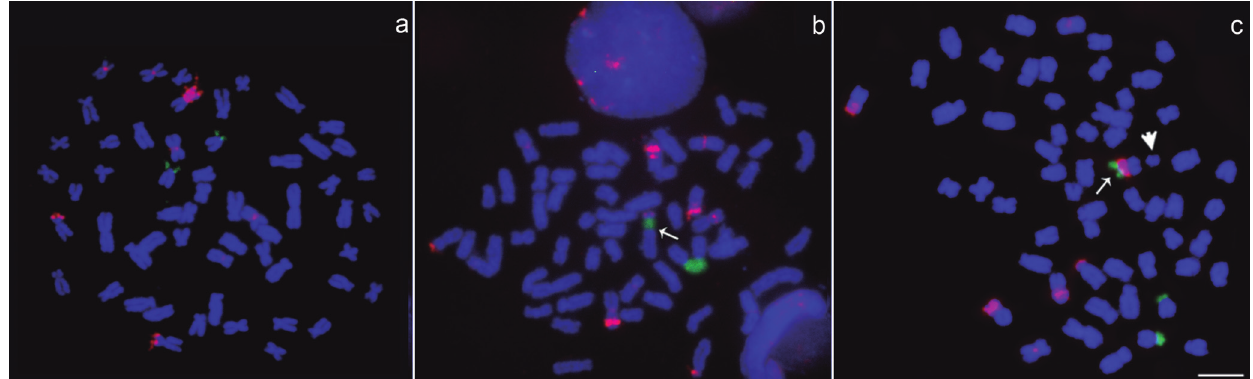
Fig. 4. Double FISH metaphases spreads of Callichthys callichthys with 5S (red) and 18S (green) rDNA probes. Standard metaphase (a) with 56 chromosomes and only the pair 25 bearing NORs. The arrows indicate the m-sm chromosome 4 with (b) 18S rDNA in interstitial position and terminal 5S rDNA and (c) 18S rDNA in terminal position. The arrowhead shows the ill-defined acrocentric B chromosome. The bar represents 5µm.